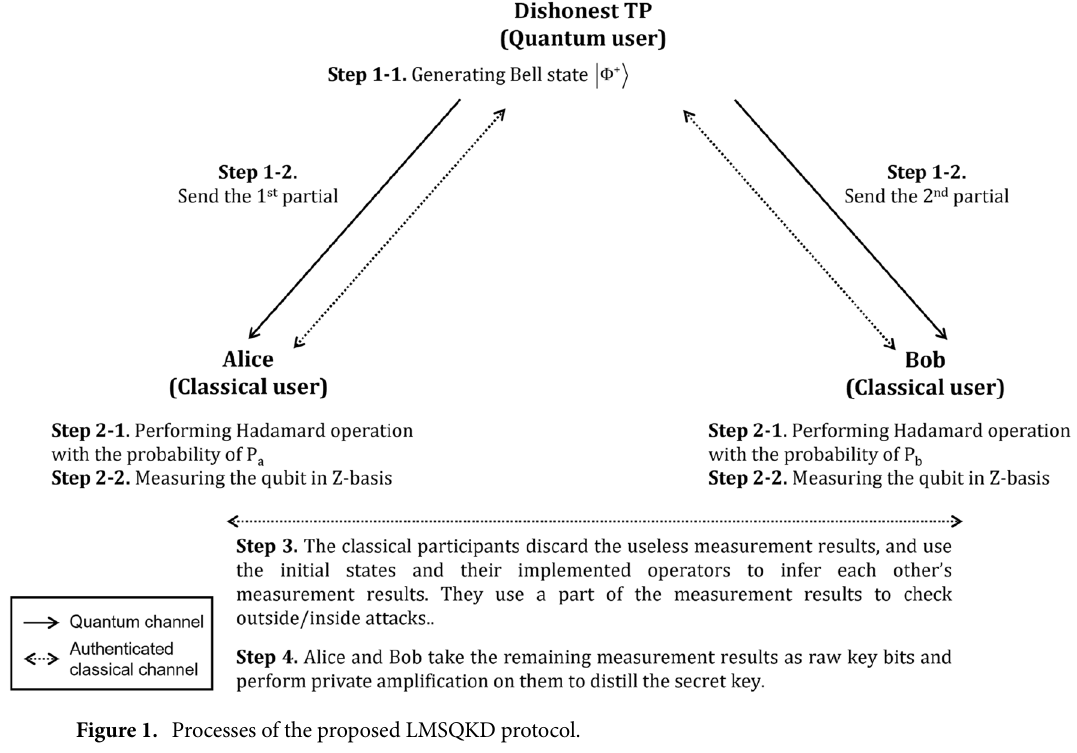
Figure 1. Processes of the proposed LMSQKD protocol.